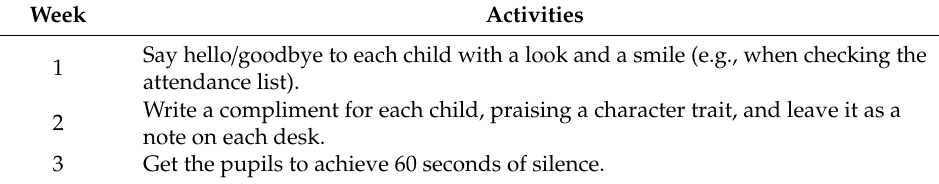
Table 3. The pre-training activities with